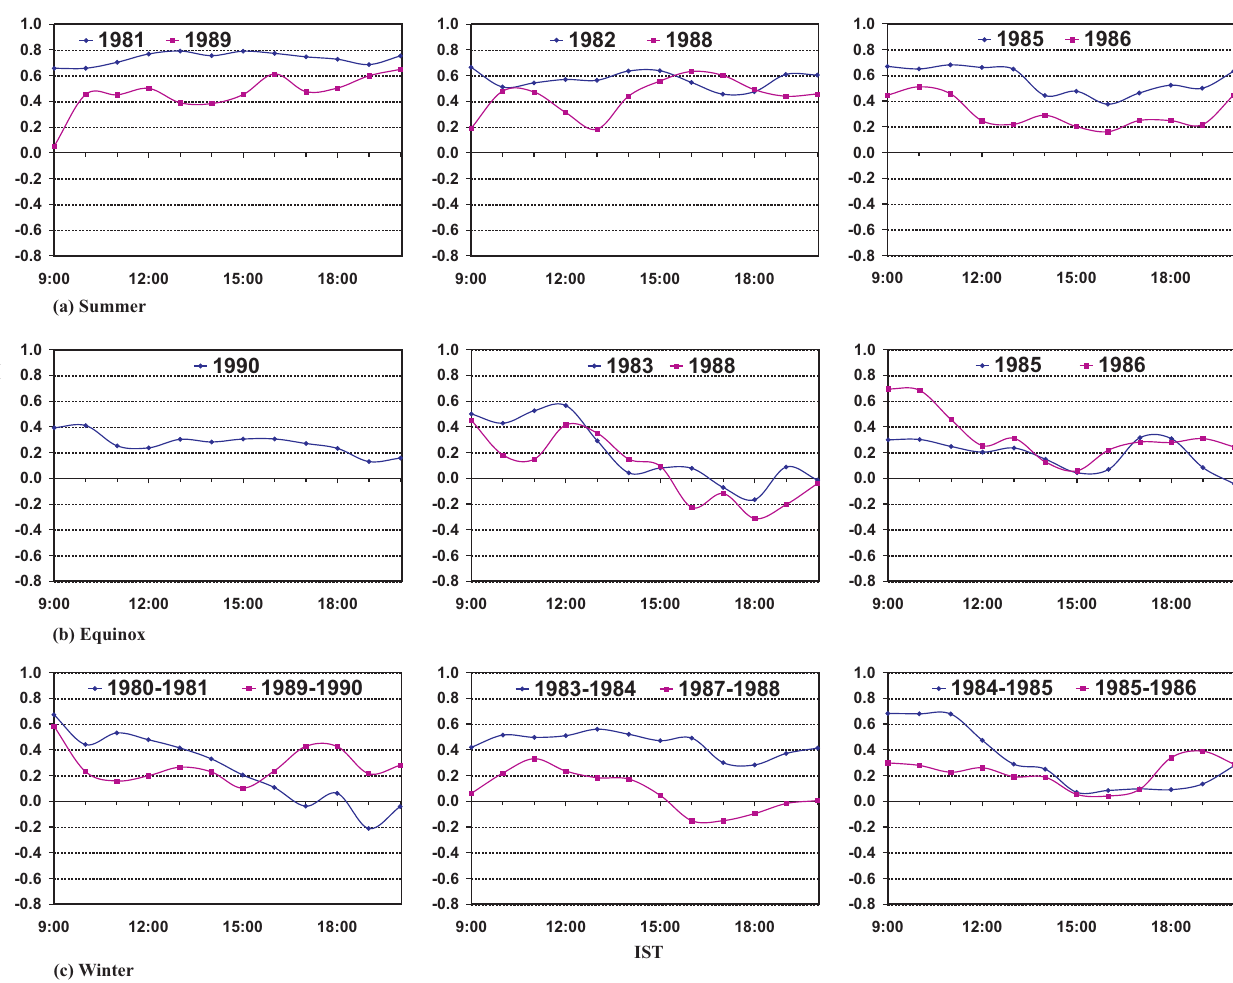
Fig. 4. Diurnal variation of correlation coefficients ( R ) between TEC and time-integrated EEJ (nT-h) for high, moderate and low solar activity years. Panels (a) , (b) and (c) refer to summer, equinoctial and winter solstitial months respectively. TEC data for the equinoctial months of high solar activity years of descending phase are incomplete due to irregular satellite